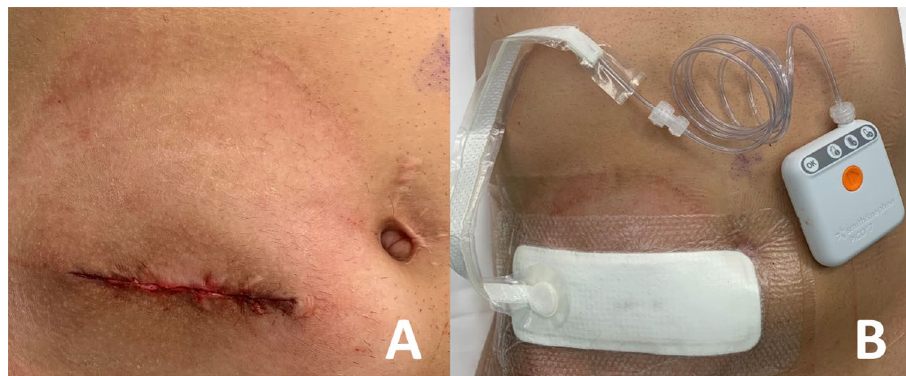
Figure 1. Wound management. Figure depicting wound management after ostomy closure. ( A ) Direct skin closure with intradermal absorbable suture. ( B ) Application of single-use closed-wound negative pressure wound therapy